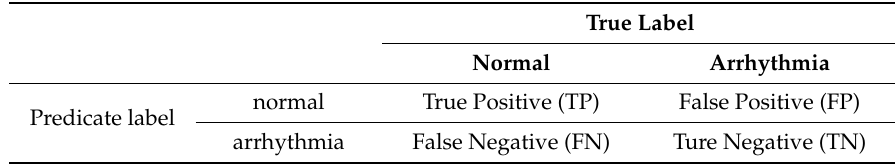
Table 2. Confusion matrix principle.